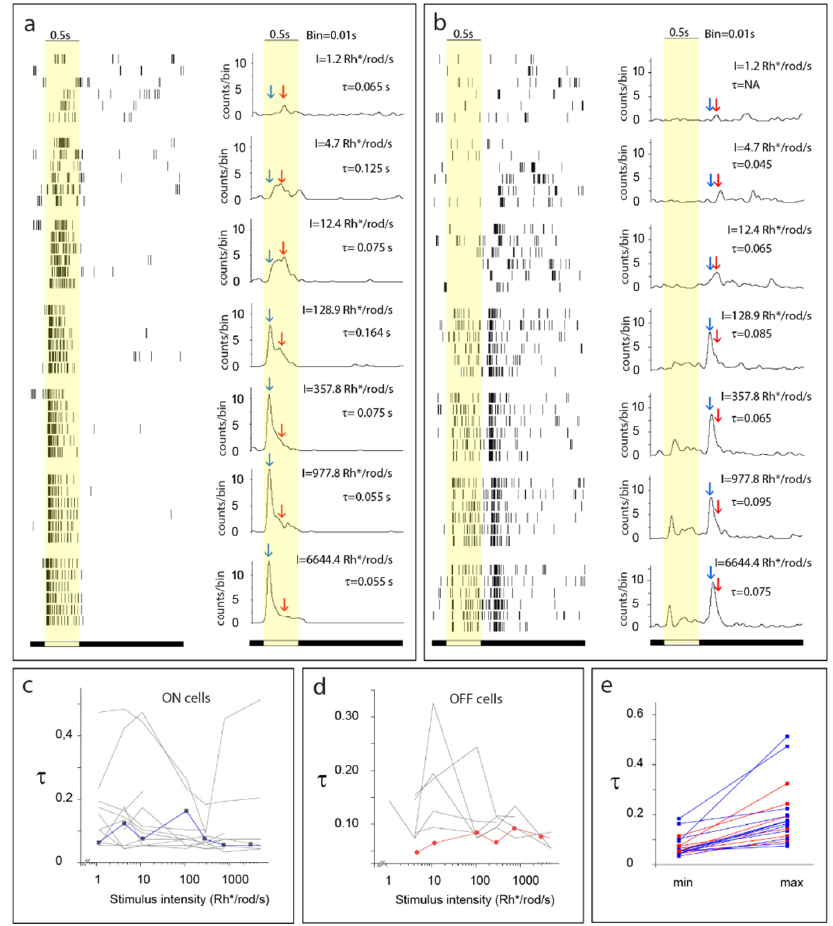
Figure 8. Signal interference through parallel retinal pathways. ( a ) Representative ON retinal ganglion cell (RGC) light-evoked rasters (left column) and peristimulus time histogram (PSTH) cohorts (right column) were obtained to light stimuli of various strength (intensity is reflected in the right top corner). RGC PSTH τ values (for more information, see [146]) changed non-monotonously during this experiment while the stimulus intensity was gradually increased (see also panel ( c )). PSTHs clearly show a very sensitive, relatively delayed response component (red arrow) and a less sensi- tive but fast response component (light blue arrow). These two components differ in their delays but appear similar in response decay, and therefore PSTH τ values are shifted towards the sustained range when the two signals are summated (mesopic conditions—2nd, 3rd, and 4th panels), whereas they appear transient when only one signal is present (scotopic condition—1st panel) or dominates over the other component (photopic conditions—5th, 6th, and 7th panels; see also panel ( c )). ( b ) A similar experiment was performed for this representative OFF RGC. PSTH τ values of this RGC